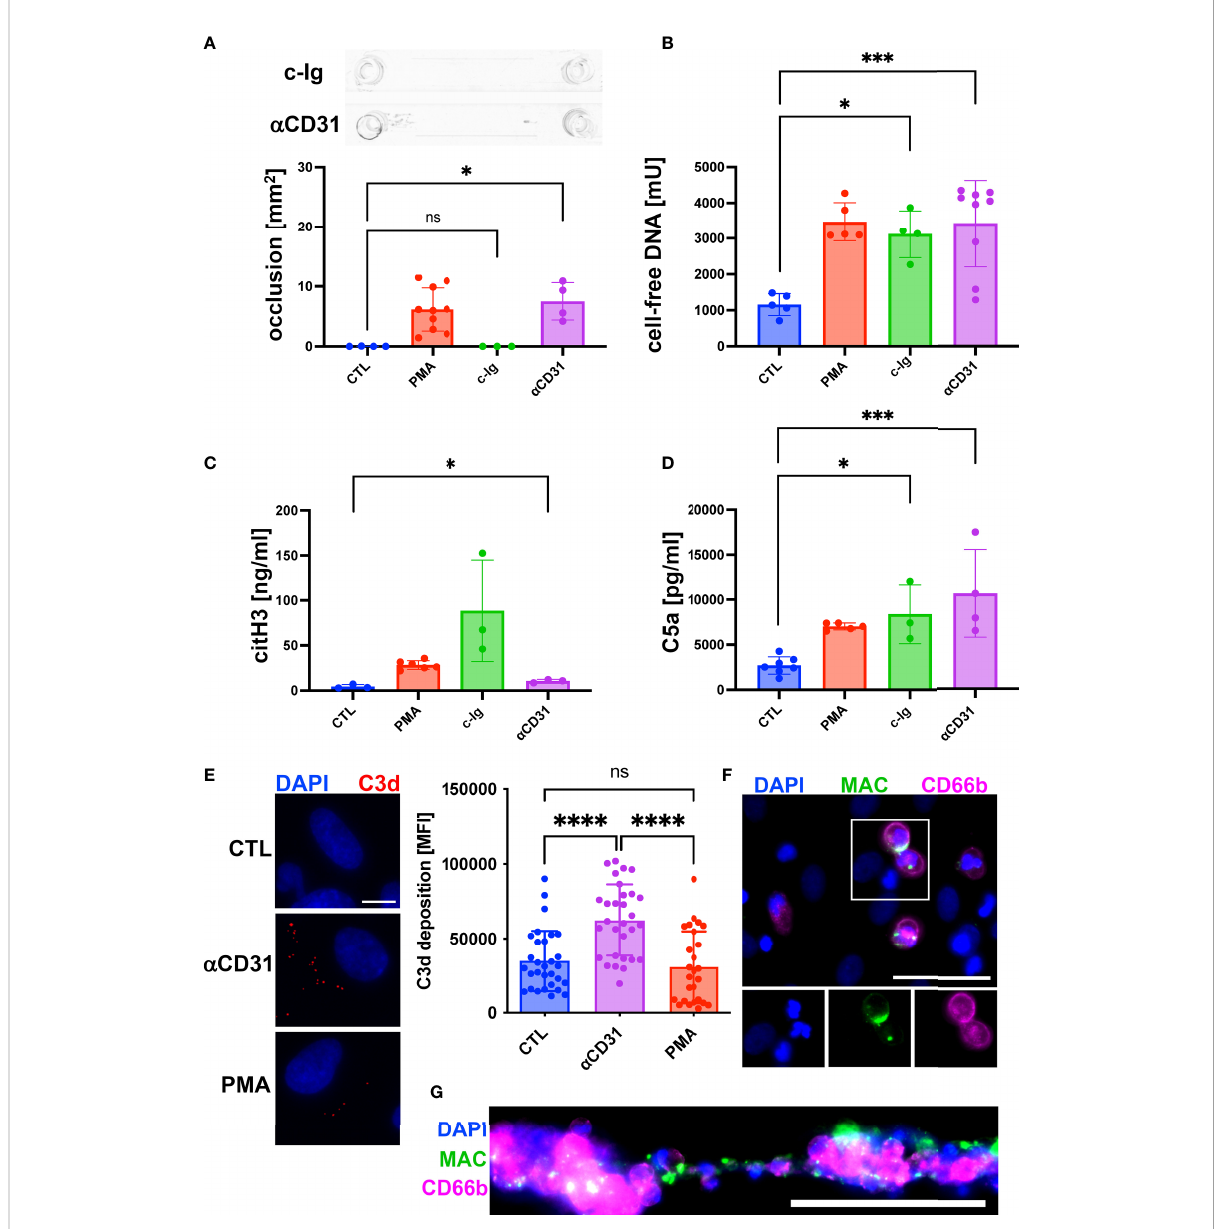
FIGURE 3 Activation of complement system promoted NETosis and channel occlusion in hirudinated whole blood. To induce complement activation in the fl uid phase, complexes of heat aggregated immunoglobulins (c-Ig) were added to the perfusing blood. To induce complement activation at the endothelium, CD31 directed antibodies ( a CD31) were deposited on the surface of HUVECs prior to the perfusion with whole blood. (A) No macroscopic channel occlusions were formed in c-Ig-treated slides, whereas channels occluded upon a CD31 treatment. (B) Plasmatic cell-free DNA was signi fi cantly increased in c-Ig- and a CD31-treated slides in comparison to the CTL group. (C) Concentration of plasmatic citH3 was signi fi cantly increased in a CD31-treated slides in comparison to the CTL group. Although c-Ig treatment increased the plasmatic concentration of citH3, the effect was statistically not signi fi cant. (D) Detection of C5a in plasma samples. In comparison to the CTL slide, C5a was signi fi cantly increased in c-Ig- and a CD31-treated slides. (E) Vascular deposition of C3d (red) was analyzed by immuno fl uorescence staining of fl ow slides after the perfusion experiment. Representative fl uorescence microscopic images are shown. Scale bar = 10 µm. Quantitative analysis of microscopy images is indicated as bar diagram. (F) MAC staining (green) of single neutrophils attached to the endothelium and (G) neutrophils/ NET conglomerates. CD66b (magenta) was used as a neutrophil marker. Scale bars = 50 µm. For reference, data of PMA-treated and CTL slides, which were already shown in Figure 2, are depicted again (A-D) . Data are shown as mean ± SD, scatter plots indicate the number of independent experiments (A-D) or the mean fl uorescence intensity (MFI) of the C3d staining per fi eld of view of three independent experiments (E) , p*<0.05, p***<0.0005, p****<0.0001, ns = not signi fi cant, one-way ANOVA with Tukey (A-E) or Dunnett ’ s T3 (C) post hoc